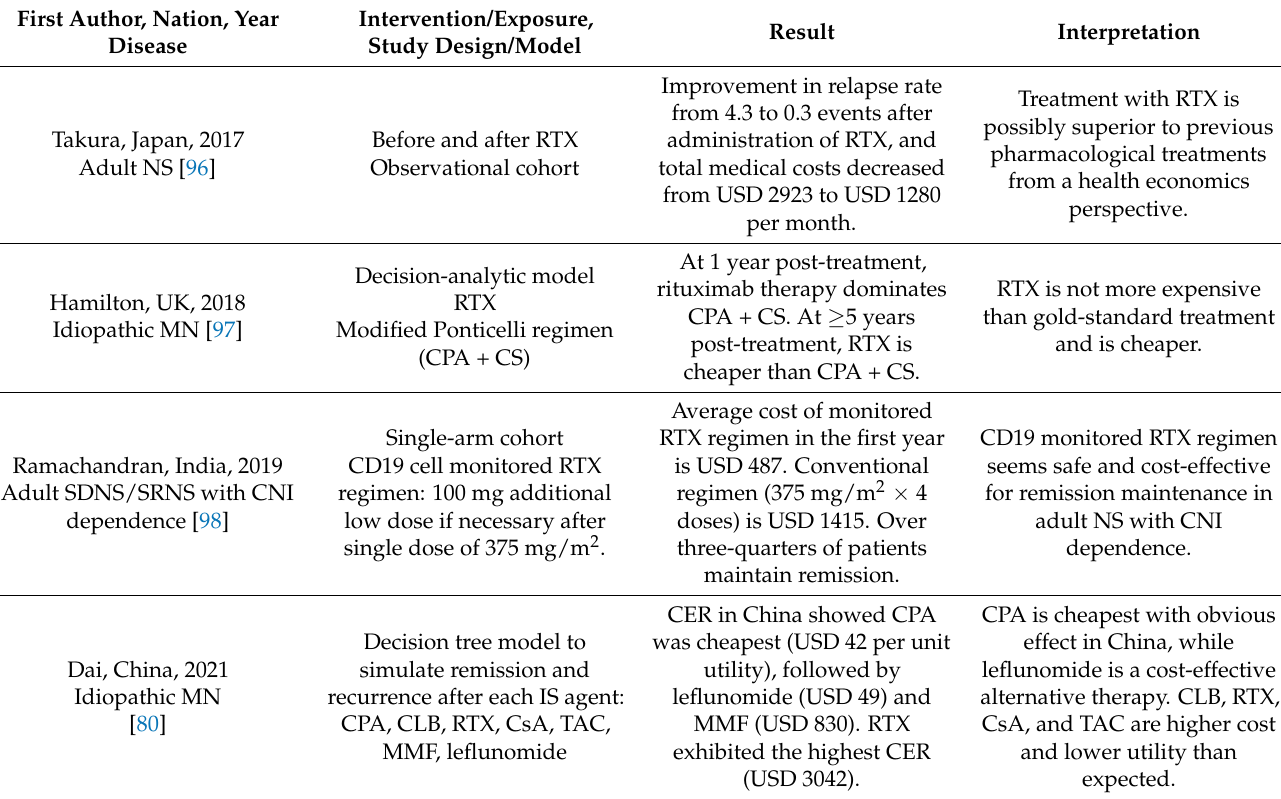
Table 3. Studies related to cost-effectiveness in treatment with IS agents for primary